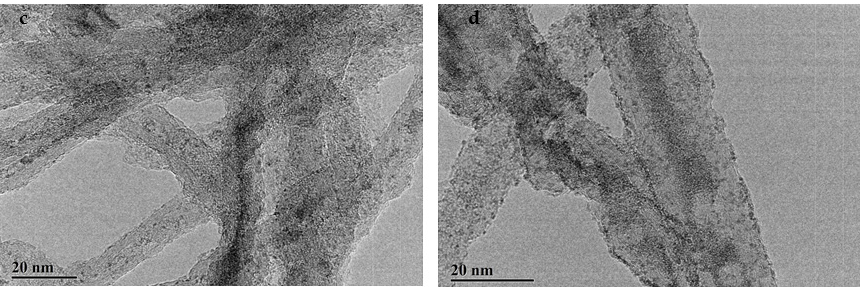
Figure 6. TEM images of 5%Re/CNTs ( a ); 5%Re ‐ 30%PW 12 /CNTs ( b ); 5%Re ‐ 30%PW 12 /CNTs 6 h post ‐ reaction ( c ) and 5%Re ‐ 80%PW 12 /CNTs ( d ).